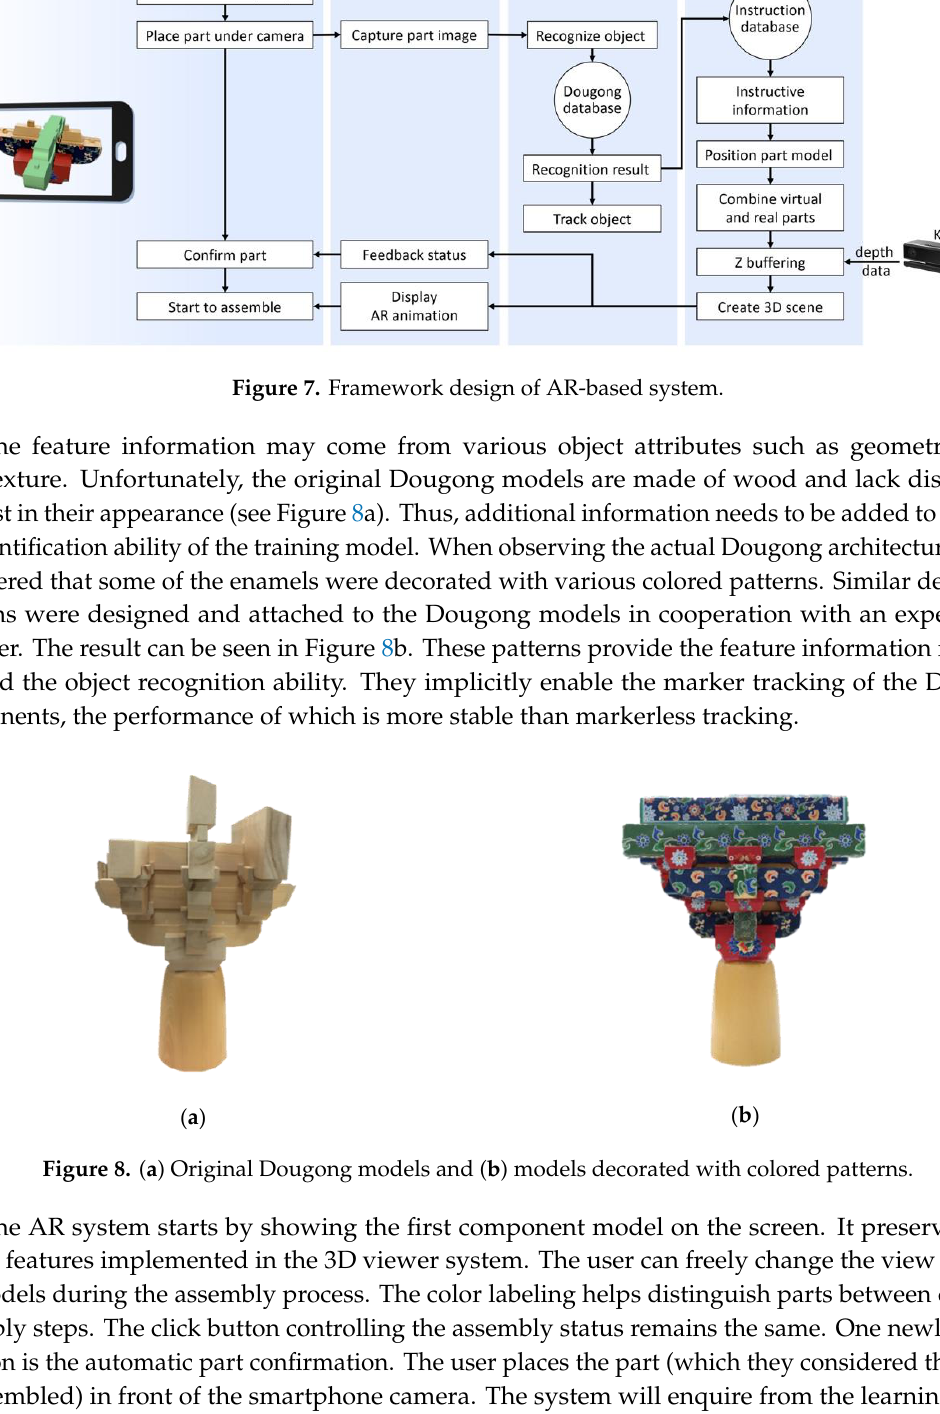
Figure 7. Framework design of AR-based system.